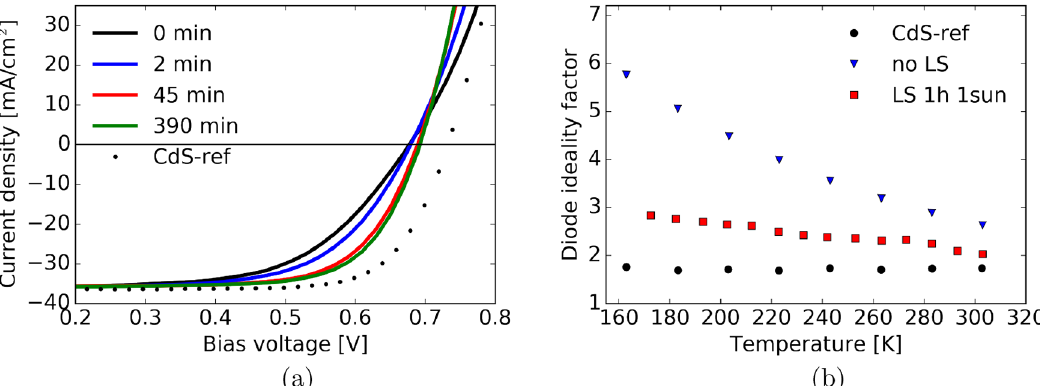
Fig. 4. (a) IV of Zn 1 (cid:1) x Mg x O buffer device before and after different light soaking duration at 1 sun. (b) Ideality factor extracted from J SC – V OC measurements for CdS reference (circle) and Zn 1 (cid:1) x Mg x O buffer device before (triangle) and after light soaking (square).